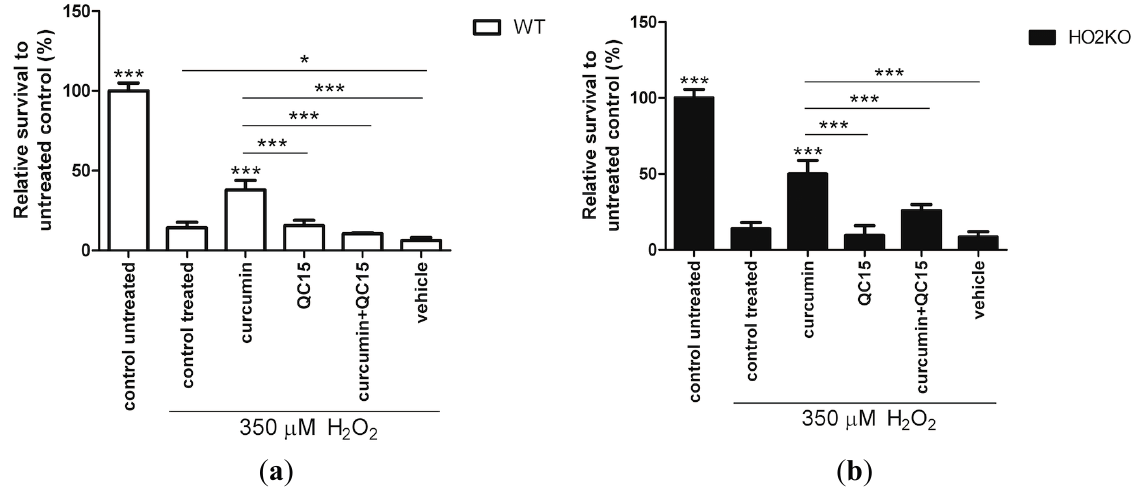
Figure 5. Inhibition of HO-activity abrogated the protective effect of curcumin against H 2 O 2 -induced cell death in isolated WT and HO-2 KO ASCs. ( a ) WT ASC and ( b ) HO-2 KO ASC survival after 24 h pre-treatment with HO-modulators or untreated (control) and 24 h co-treatment together with 350 µM H 2 O 2 as measured by Alamar blue assay and fluorimetric quantification, related to untreated control. Vehicle consisted of 0.5% ethanol (curcumin solvent) in culture media. * is significant different from treated control. ( * p < 0.05, and *** p < 0.001). Data represent a representative of three independent experiments and present mean ± SD. For each condition six samples were